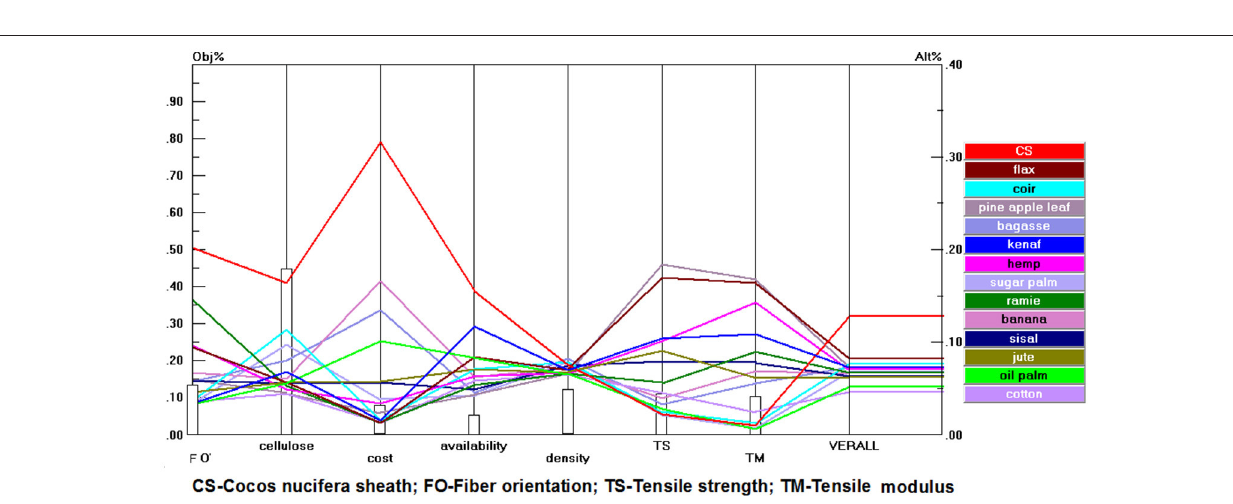
vectors assigned to the main criteria. Thus, changing the eigen vector of the main criteria (either decreasing and increasing) will change the ranks of the alternative candidate materials (Mansor et al.,